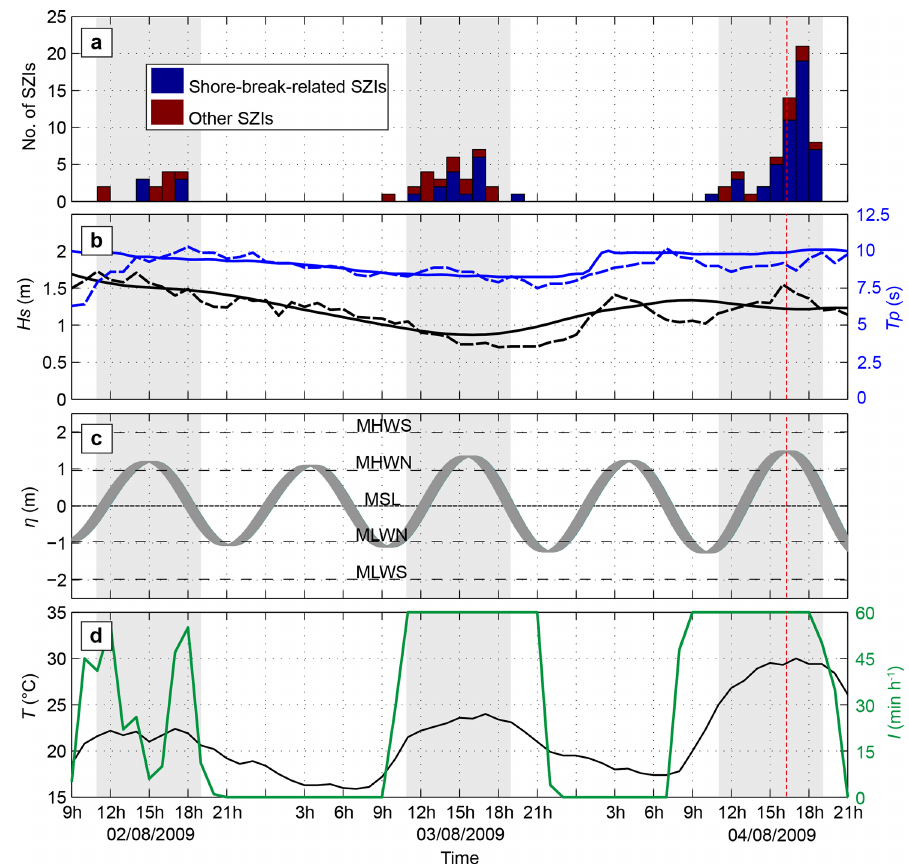
Figure 10. Time series on 2–4 August 2009, with 4 August having the largest number of shore-break-related injuries in the entire dataset, showing (a) distribution SZIs with indication of shore-break-related injuries; (b) significant wave height, Hs , and peak wave period, Tp , from the model (solid) and from the Candhis directional wave buoy in 50m depth facing Truc Vert, which only worked intermittently during the three summer seasons; (c) tide elevation, η ; (d) hourly air temperature, T , and insolation, I . In all panels, the light grey areas show lifeguard-patrolled hours. In all panels the vertical dashed red line indicates low-tide occurrence on 4 August